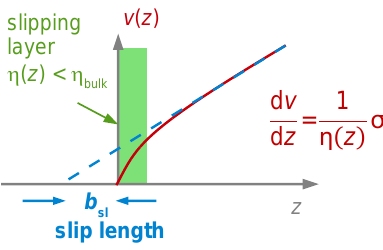
Figure 25. A decreased viscosity close to an interface moves the extrapolated plane of zero shear to negative z . The distance between the plane of zero shear and the surface is the slip length, b sl .